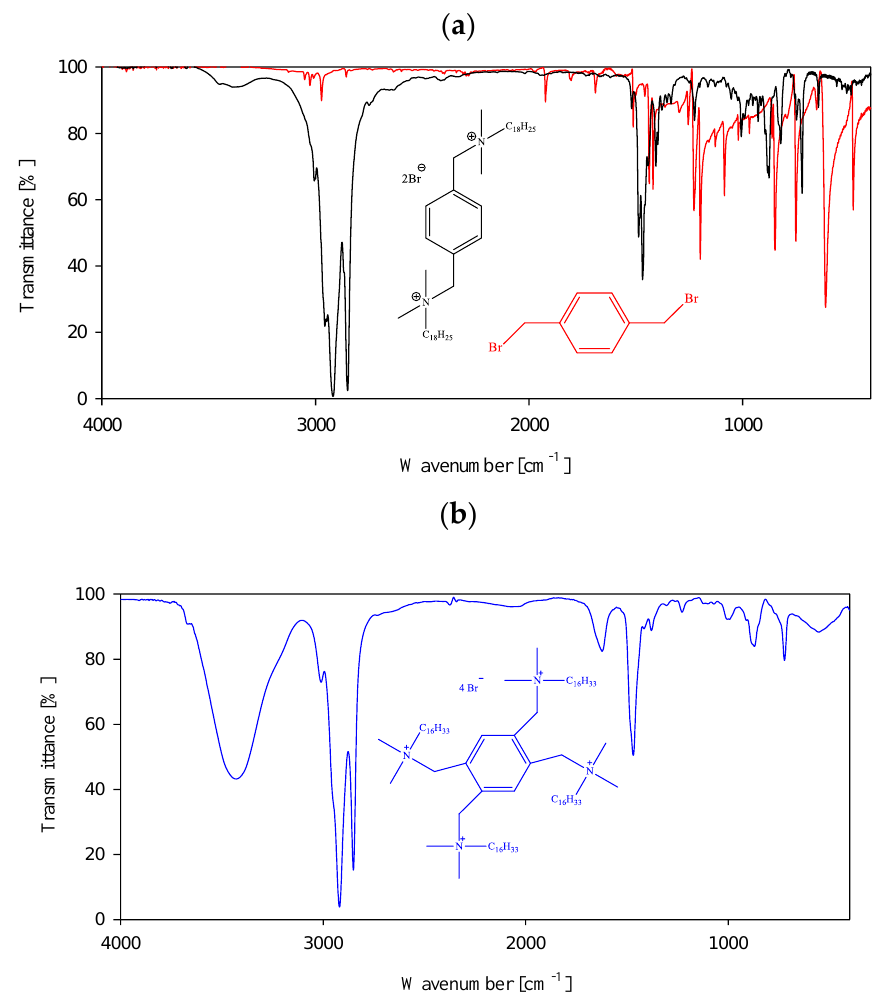
Figure 5. FT-IR spectra (KBr pellets) of 1,2-di(bromomethyl)benzene ( ― ) and 9 ( ― ) ( a ) and 23 ( ― ) ( b ).